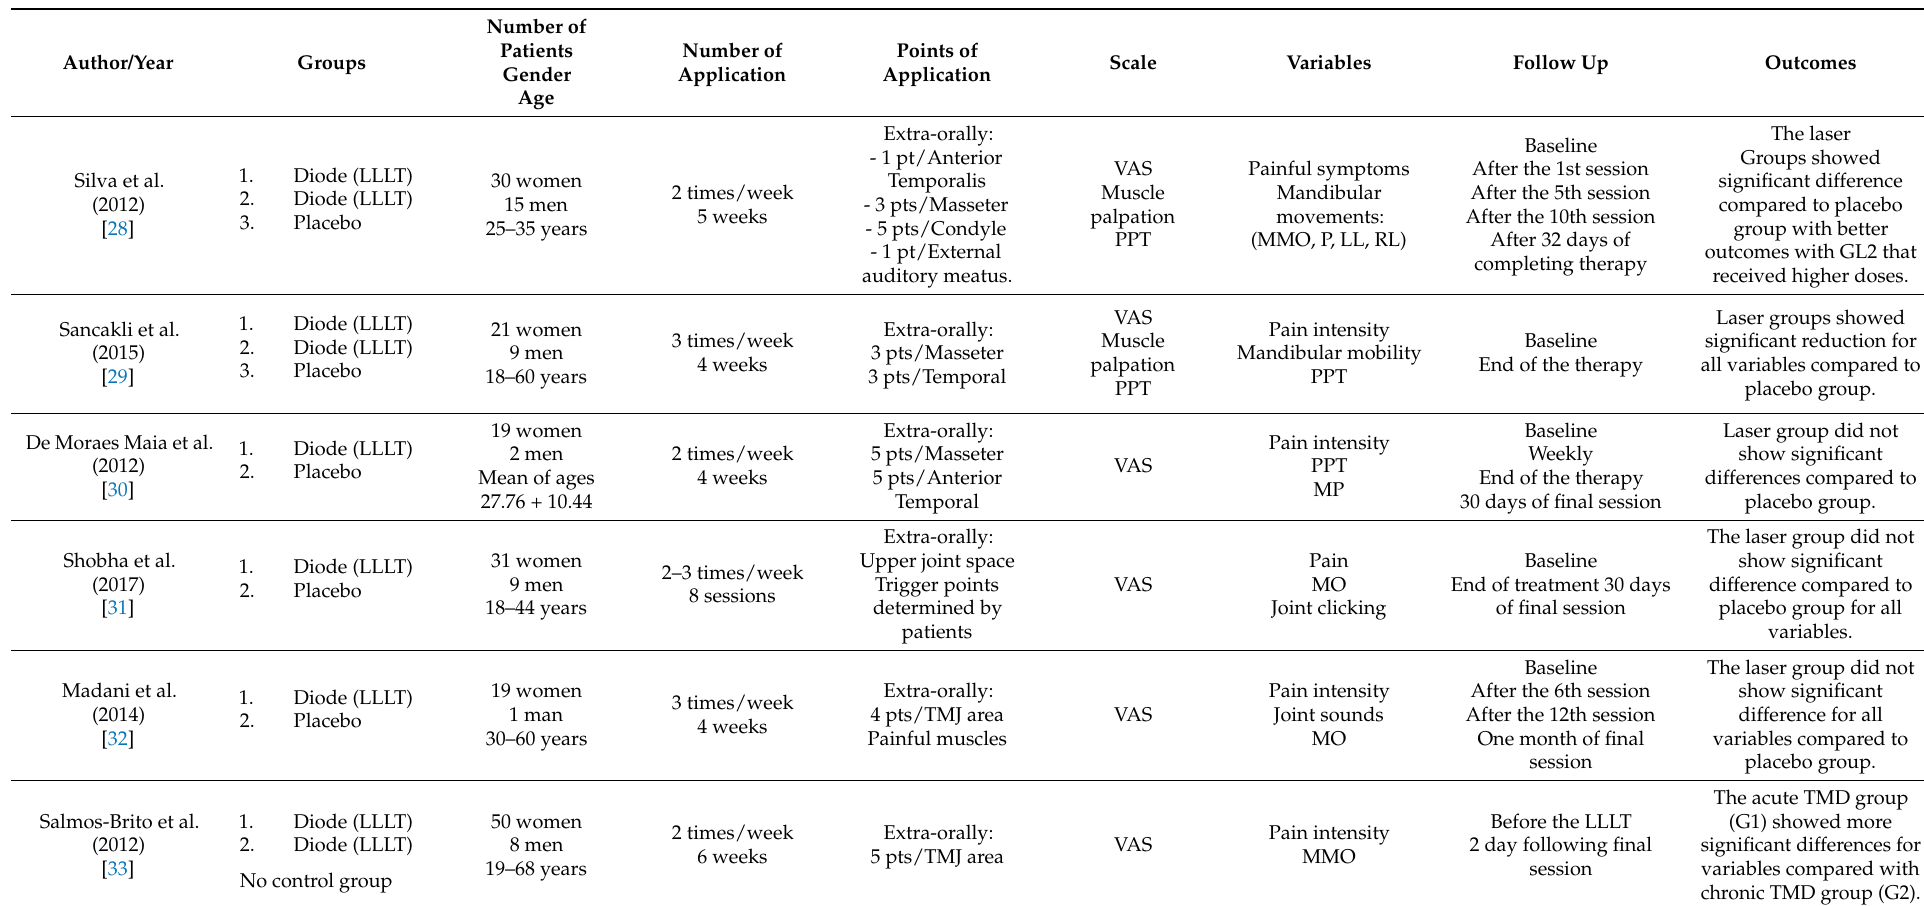
Table 1. Summary of included studies. LLLT, Low-Level Laser Therapy; VA, visual analog scale; MM, maximum mouth opening; M, mouth opening; P,